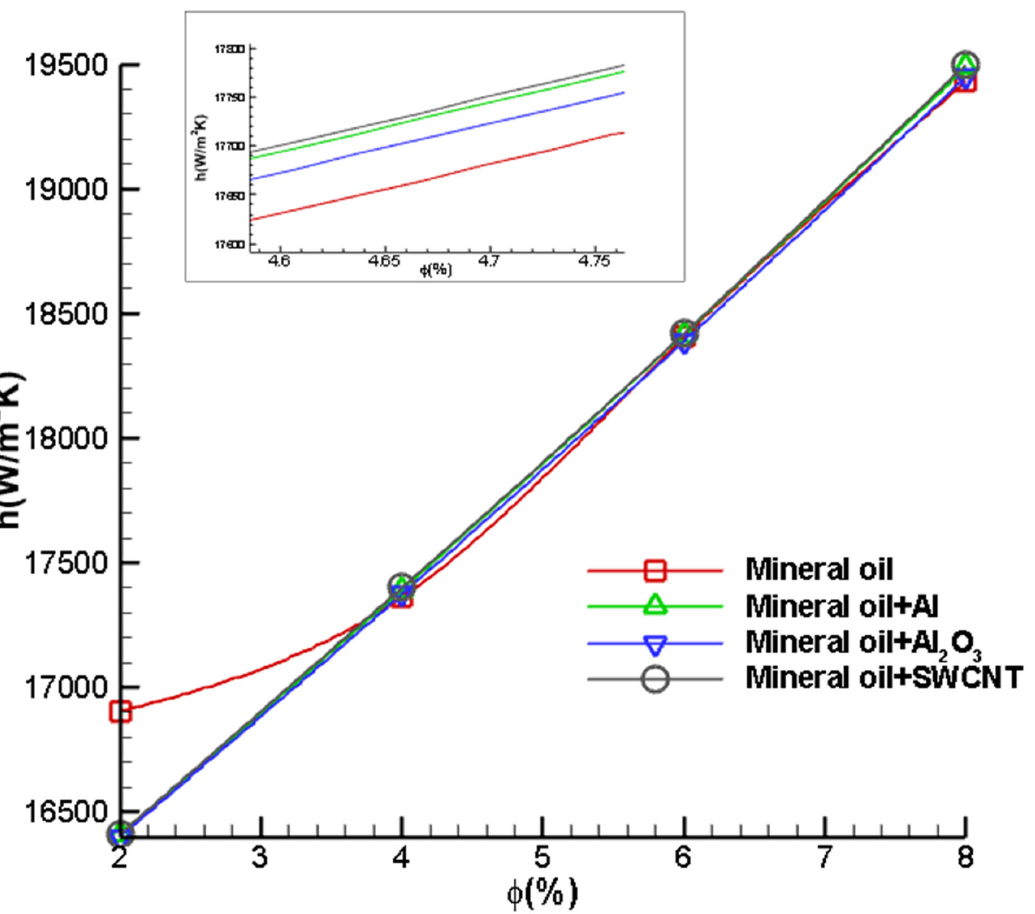
Figure 13. Variation in the convective heat transfer coefficient of the cutting tool with different volume fractions of dispersed nanoparticles.